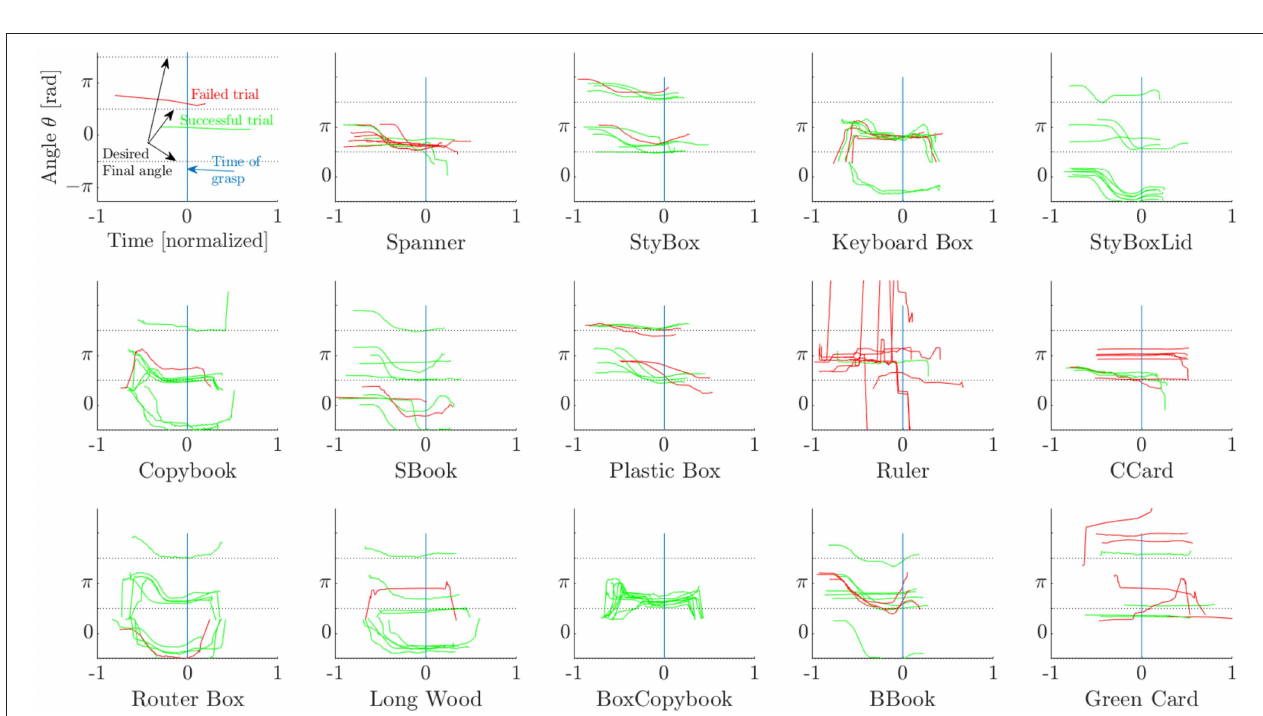
FIGURE 11 | Strategy 2: object orientation angle trajectory for each object and trial. (Top left) Symbol explanation.